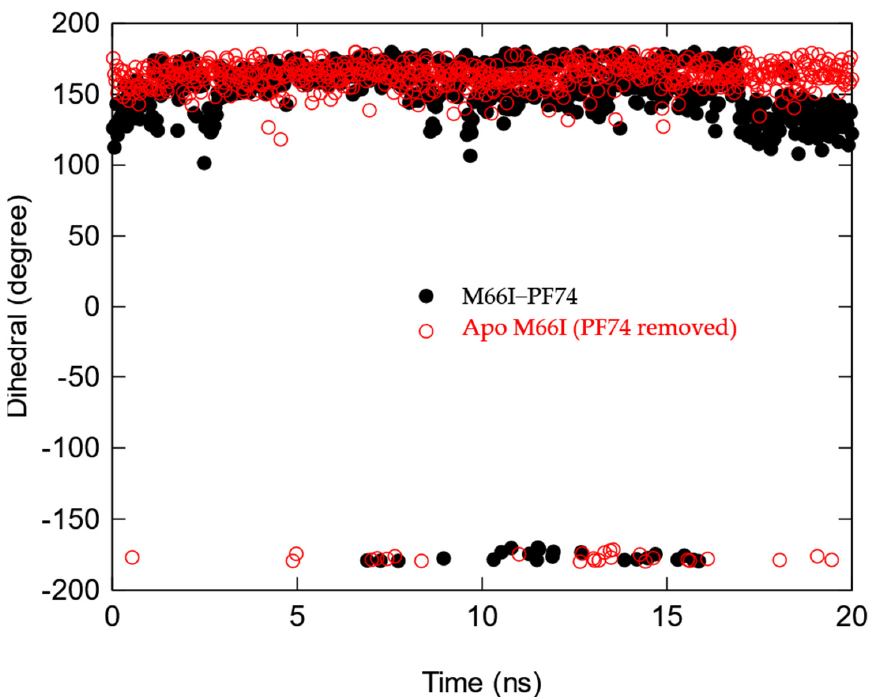
Figure 7. Time course of the   torsion in the side chain of I66 of the M66I CA mutant after the